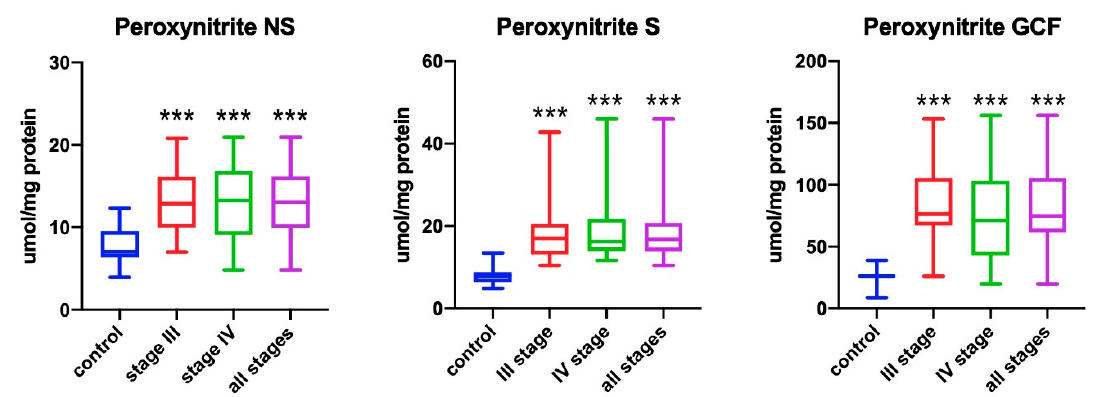
Figure 2. Concentrations of peroxynitrite in non-stimulated saliva (NS), stimulated saliva (S), and gingival crevicular fluid (GCF) in all patient groups. *** p < 0.001 versus control group .